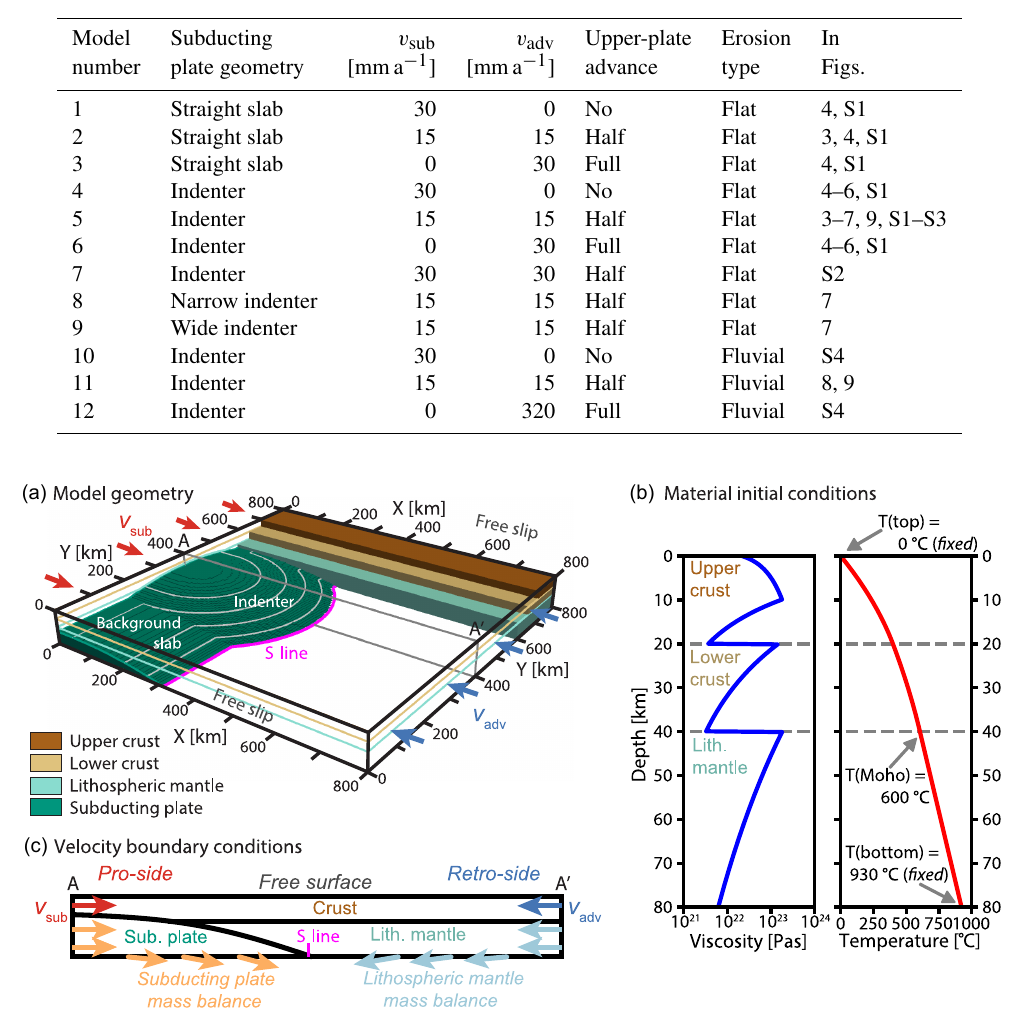
Figure 2. Model setup and properties. (a) Cut-out oblique view of the model domain illustrating the geometry and material layers: the over- riding plate is divided into an upper and lower crust and lithospheric mantle. The down-going plate is of uniform rigid material. (b) Velocity boundary conditions. Horizontal material influx with v sub from the left ( x = 0km) and v adv from the right ( x = 800km), and continued transport towards the S line along the bottom boundary. Material influx of subducting plate and lithospheric mantle is compensated for by rotational motion of the subducting plate and outflux of the lithospheric mantle increasing towards the center; i.e., only crustal influx is added to the domain. Additionally, vertical velocities are modified by isostasy. Velocity boundary conditions along front and back ( y = 0 and y = 800km) are free slip; top is free surface. (c) Vertical profiles of the overriding plate effective viscosity and initial temperature conditions. Temperature boundary conditions are fixed temperatures at bottom and top, and zero flux is imposed at all horizontal sides. Detailed material parameters are given in Table